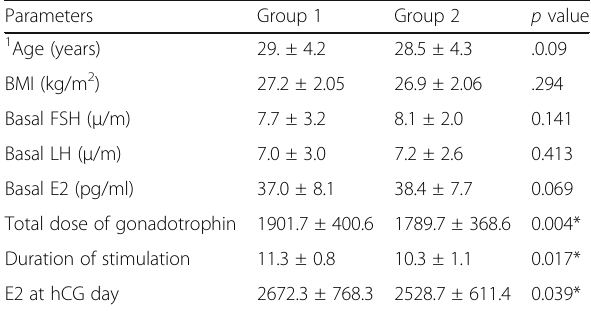
Table 2 The baseline characteristics of the studied